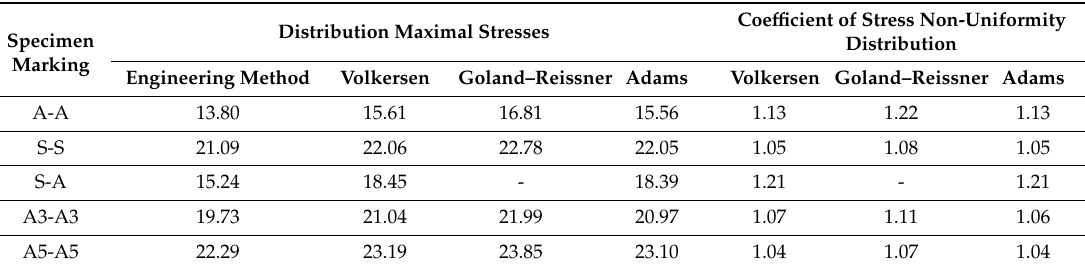
Figure 19. Distribution of stress determined by analytic methods: ( a ) engineering method, ( b ) Volkersen method, ( c ) Goland–Reissner method, ( d ) Adams–Pepiatt method. Table 6. Maximal values of shear stress and stress distribution non-uniformity coefficients calculated analytically for failure forces obtained from the experiment.